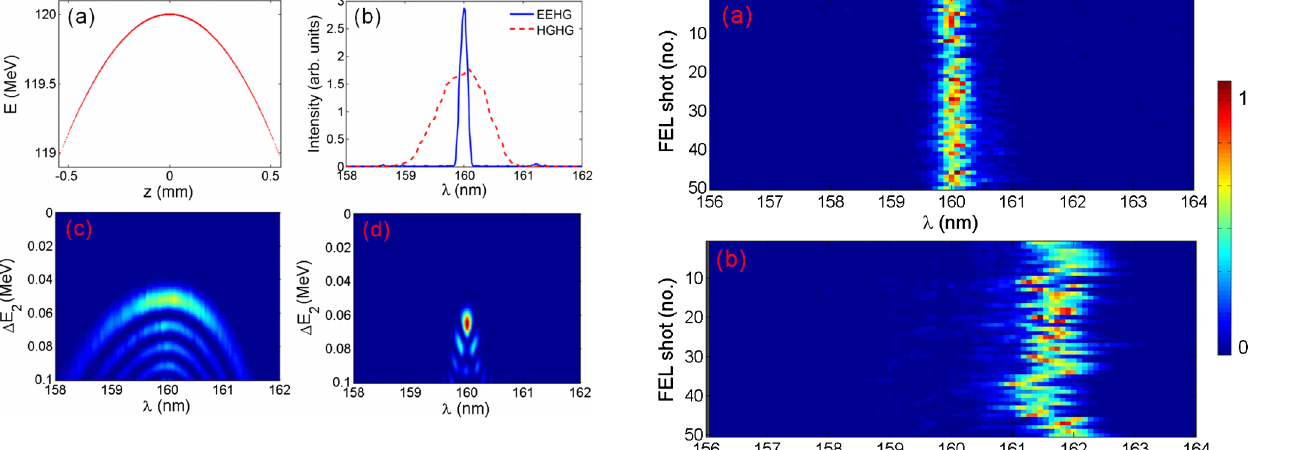
FIG. 6. Electron beam longitudinal phase space at the entrance to the EEHG beam line (a); simulated optimal EEHG and HGHG radiation spectra (b); HGHG spectra for various energy modu- lations (c); EEHG spectra for various energy modulations (d). (c) and (d) use the same scaling as Fig. 4.